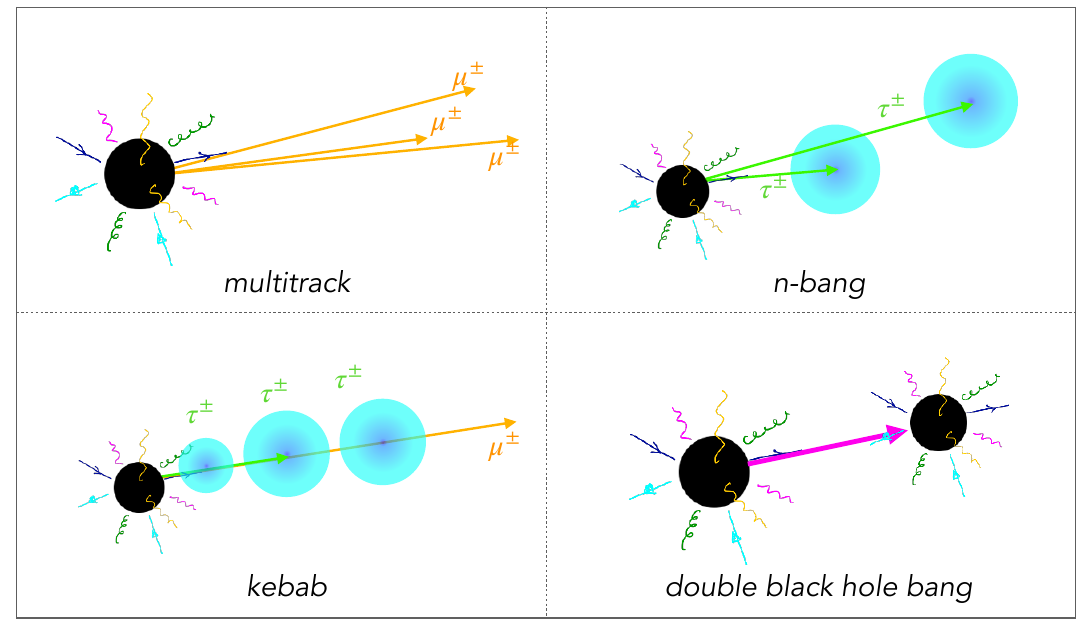
Figure 7 . New event topologies that can arise from neutrino-nucleus interactions that result in the creation of a microscopic black hole. See text for technical description. Here we represent the black hole as a black circle. Because most evaporation products will be hadronic, electronic, or low-energy products of weak decays, there will always be a cascade at the interaction vertex. High-energy muons which propagate large distances in the ice are shown as orange arrows. The blue circles represent hadronic or electronic decays of energetic tau leptons resulting in time-delayed cascade (\bang") signatures. Note that opening angles are greatly exaggerated: because the collisions are highly boosted, these will be well below 10 (cid:0) 2